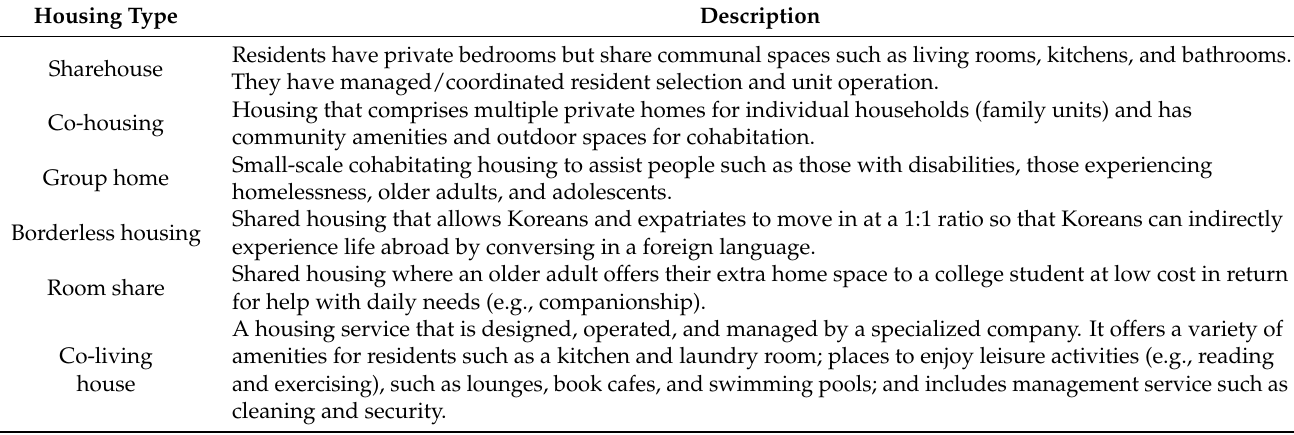
Table 1. Housing types similar to sharehouses in Korea.